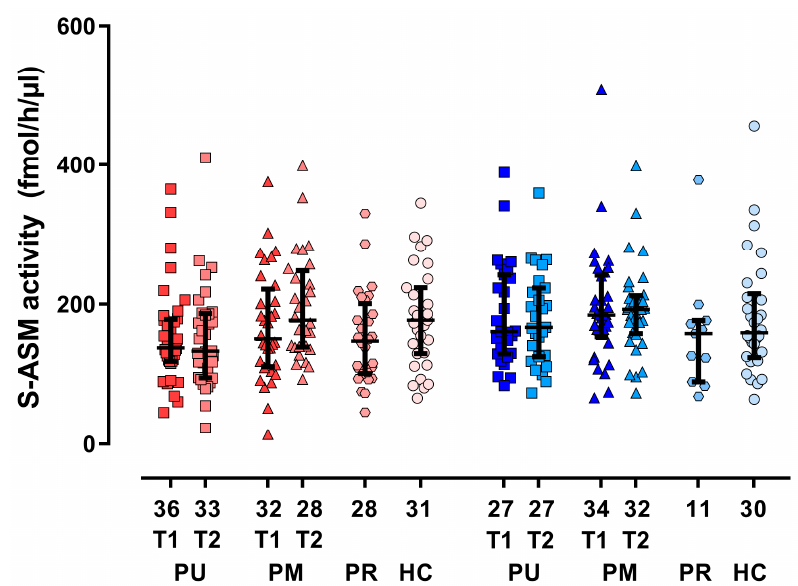
Figure 1. Serum acid sphingomyelinase (S-ASM) activity for female (red) and male (blue) subgroups of patients with a current major depressive episode (PU unmedicated, PM medicated, T1 at inclusion, T2 at follow-up approximately 3 weeks later), patients in remission (PR), and healthy controls (HC). Boxplots show individual data, the median and the interquartile range. The numbers of male and female individuals are provided below the x-axis.